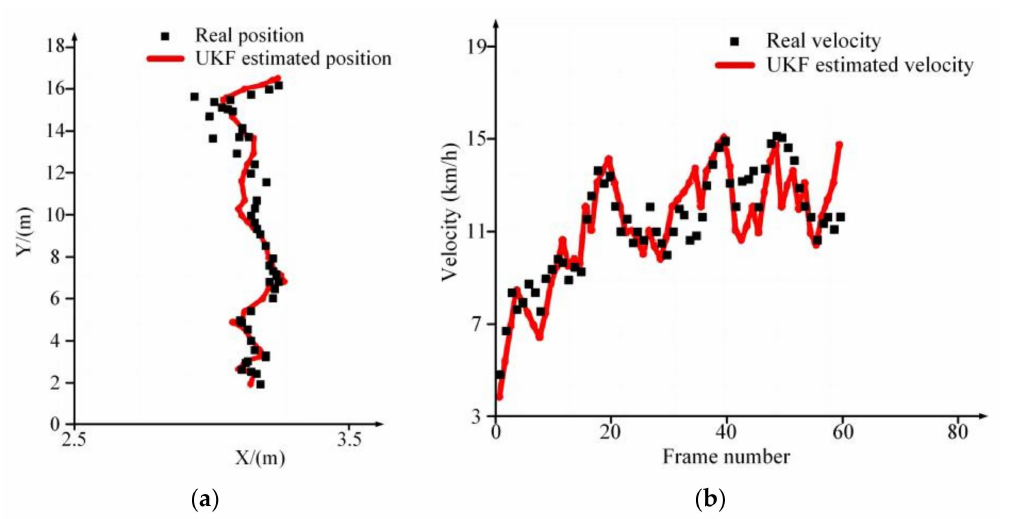
Figure 9. Obstacle status update diagram.